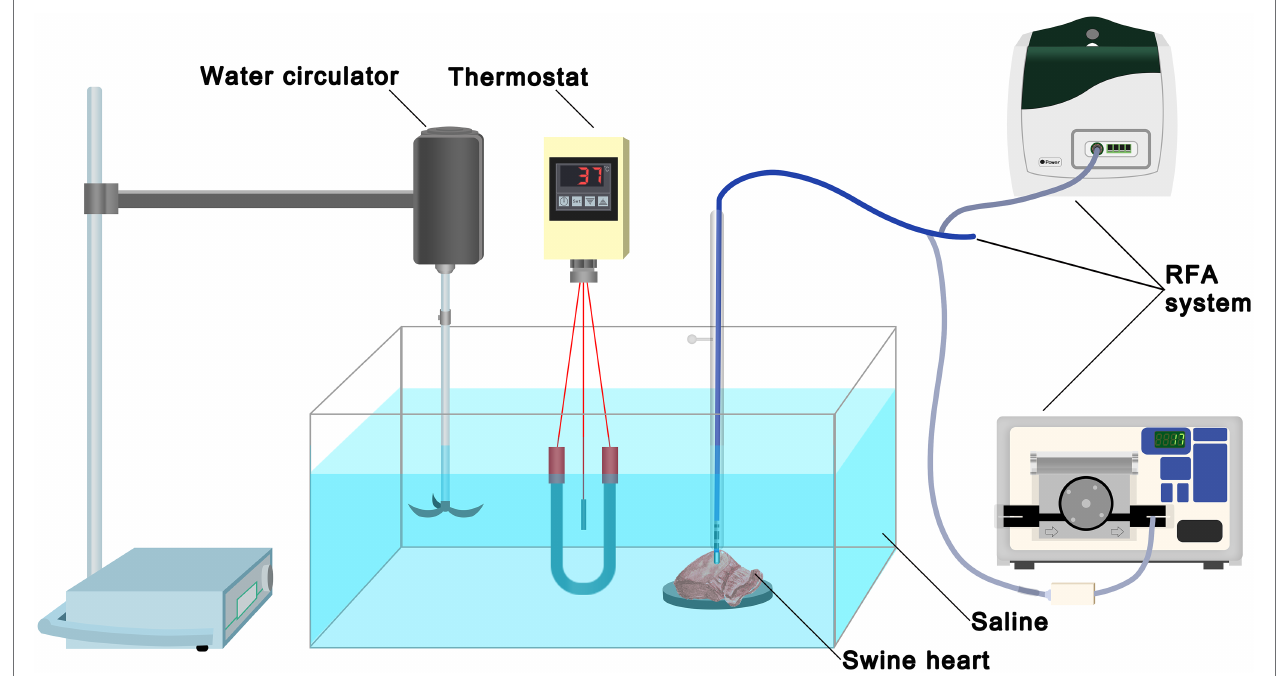
FIGURE 2 | Experimental set-up. The experimental instruments consisted of a container with 0.9% saline, a thermostat, a water circulator, and an RFA system. The thermostat maintained the temperature of saline at 37 ° C and the water circulator continuously circulated the saline. Swine heart tissue was secured on a rubber plate in the saline container. RFA, radiofrequency